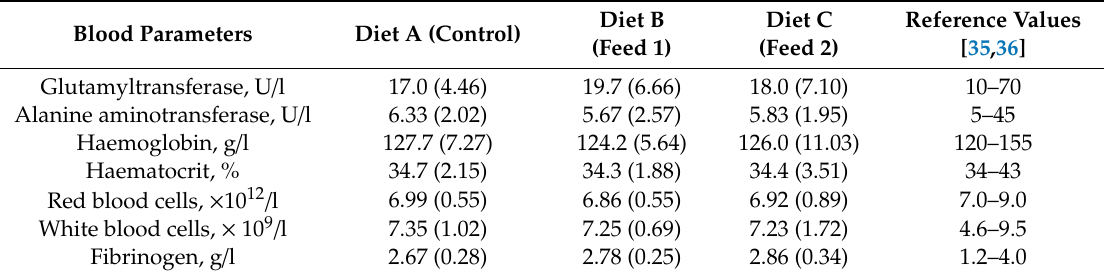
Table 6. Average values of blood parameters and standard deviations (s.d.) for the horses in the control and experimental